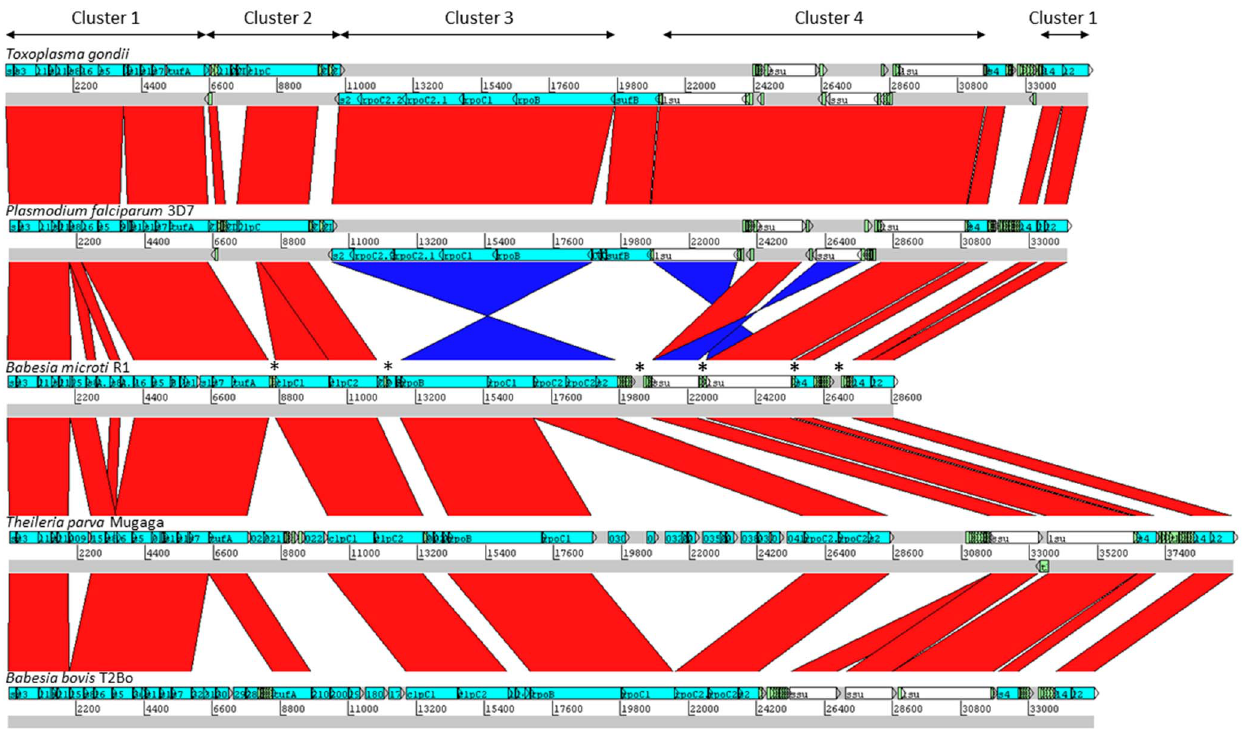
Figure 2. Schematic representation of gene clusters in the apicoplast genomes of various apicomplexan parasites. Comparison was performed using Mauve and BLAST analyses. The red and blue bars between chromosomal DNA sequences represent highly conserved regions in the forward and reverse directions respectively. Only highly conserved and syntenic regions were included in the present analysis. tRNA genes are marked by *.